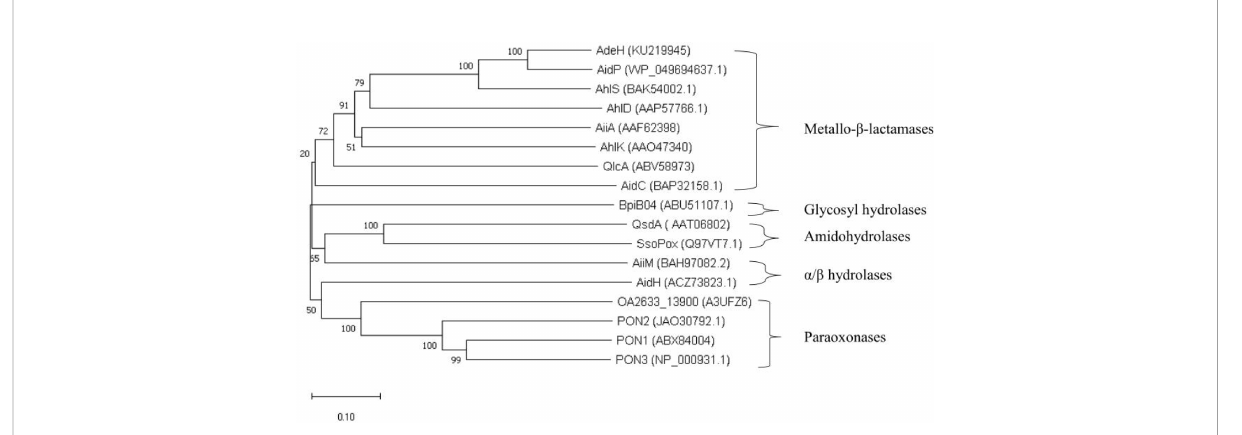
FIGURE 4 Phylogenetic tree of AHL lactonases. In this tree, the AHL-quenching enzymes are categorized into fi ve families, and these quenching enzymes as follows: AidP (See-Too et al., 2017); AdeH (Garge and Nerurkar, 2016); AhlS (Morohoshi et al., 2012); AhlD (Park et al., 2003); AiiA (Dong, 2000); AhlK (Park et al., 2003); QlcA (Riaz et al., 2010); AidC (Wang et al., 2012); BpiB04 (Schipper et al., 2009); AiiM (Wang et al., 2010); AidH (Fan et al., 2020); QsdA (Hong et al., 2012); SsoPox (Park et al., 2006); OA2633_13900 (Oh et al., 2011) ; PON1, PON2, PON3 (Bar-Rogovsky et al., 2013). Using MEGA10.2.3, the 17 protein sequences were aligned by ClustalW, and the tree was constructed according to the neighbor- joining